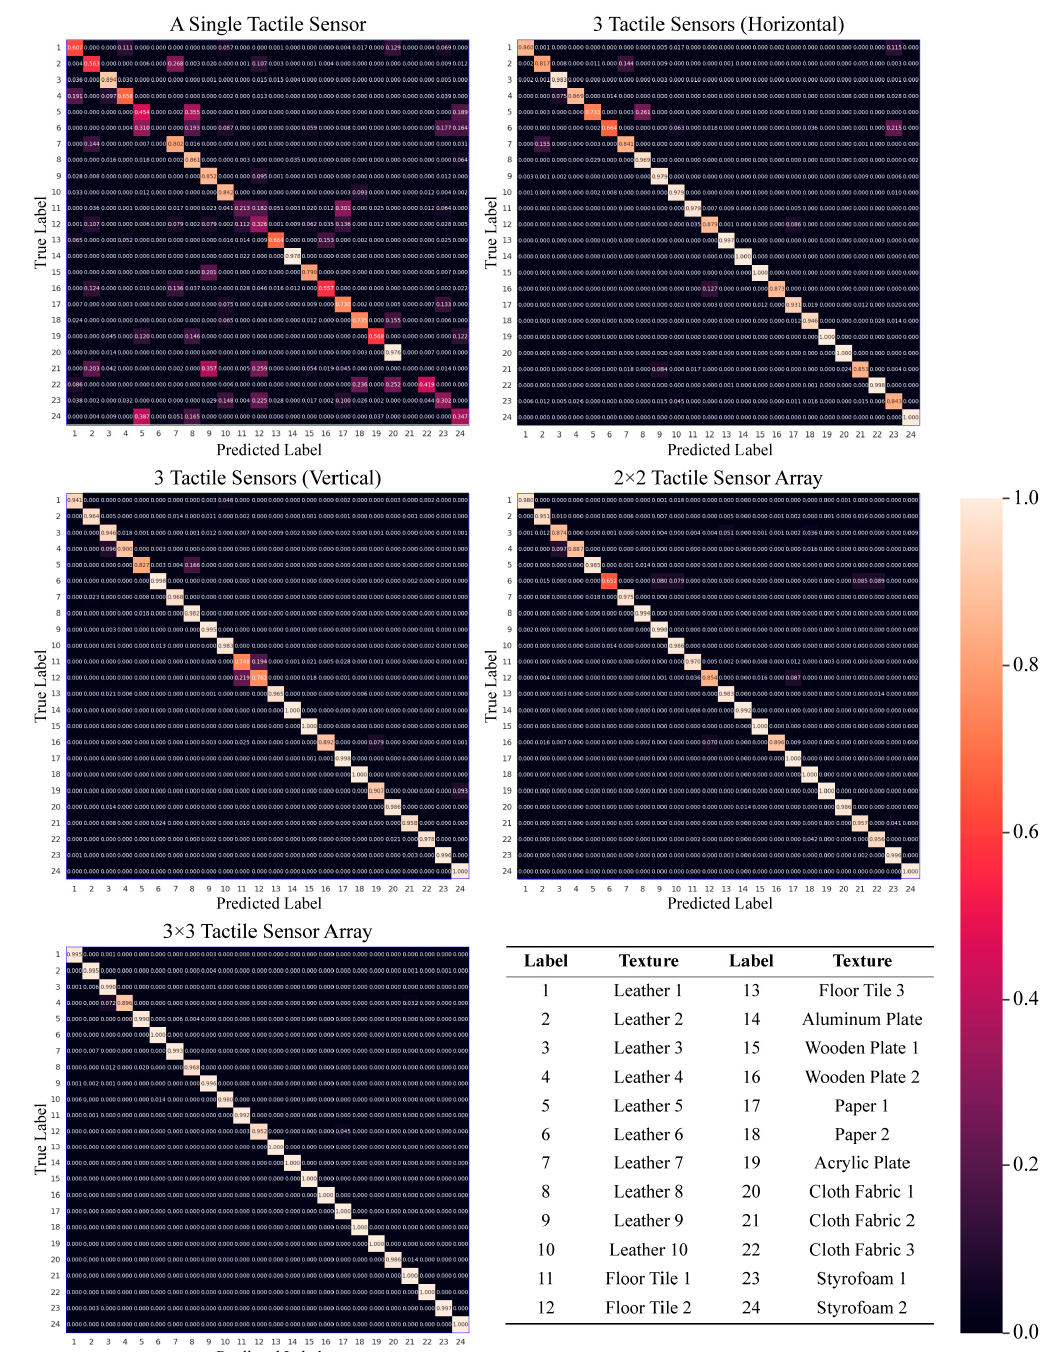
Figure 6. Confusion matrix of texture classification to compare the effects of sensing tactile arrays. The average accuracy for a total of 24 textures, represented by the main diagonal elements of the confusion matrix, is 58.913% for a single tactile sensor, 91.648% for three tactile sensors (horizontal), 94.572% for three tactile sensors (vertical), 95.292% for a 2 × 2 tactile sensor array, and 98.876% for a 3 × 3 tactile sensor array. The color bar located at the bottom right indicates the degree of accuracy, with lighter colors indicating higher accuracy and darker colors indicating lower accuracy. The order of textures in the true label and predicted label of the four confusion matrices corresponds to the order of textures listed in Figure